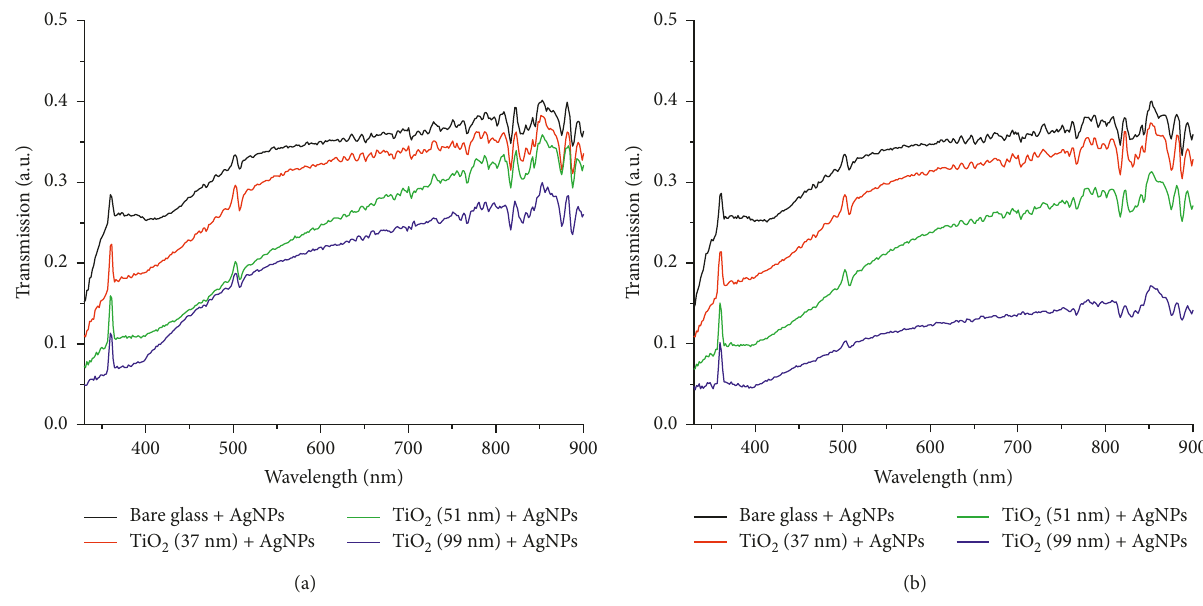
Figure 9: Transmission spectra of TiO 2 thin films decorated with AgNPs of varied film thickness in air (a) and CO 2 gas flow